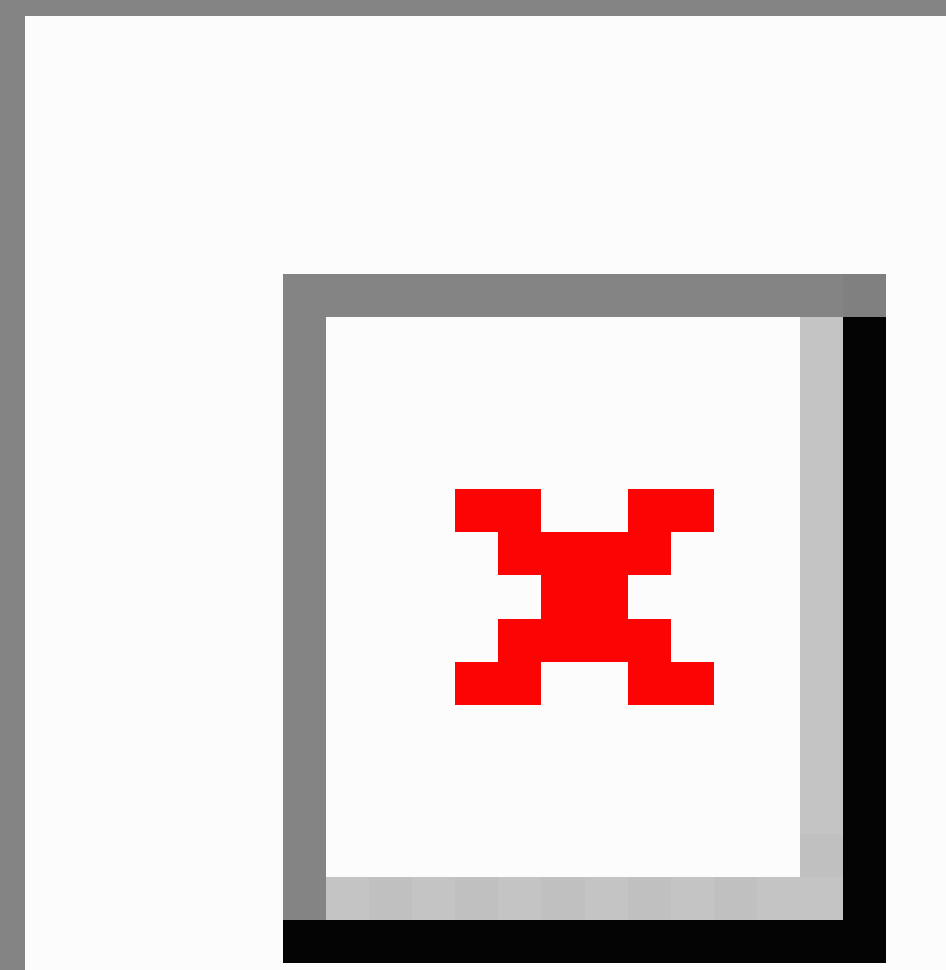
Figure 1. CONSORT flow diagram of the participation progress through the